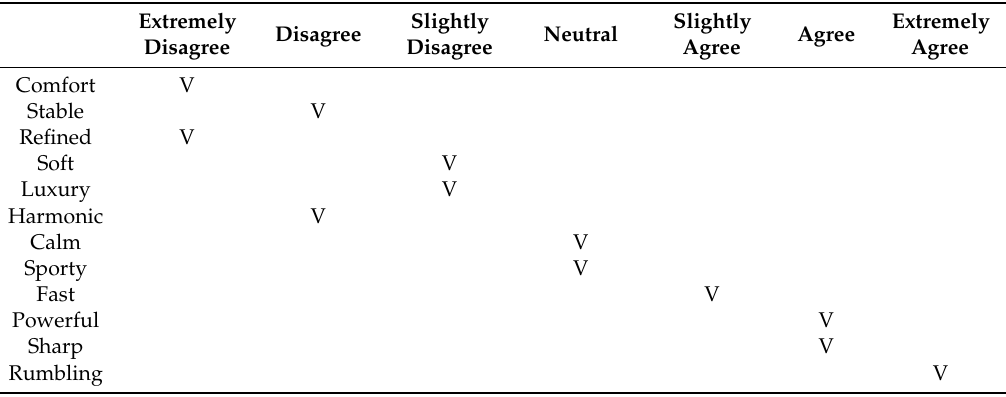
Table 2. Seven-point Likert’s scale questionnaire for this